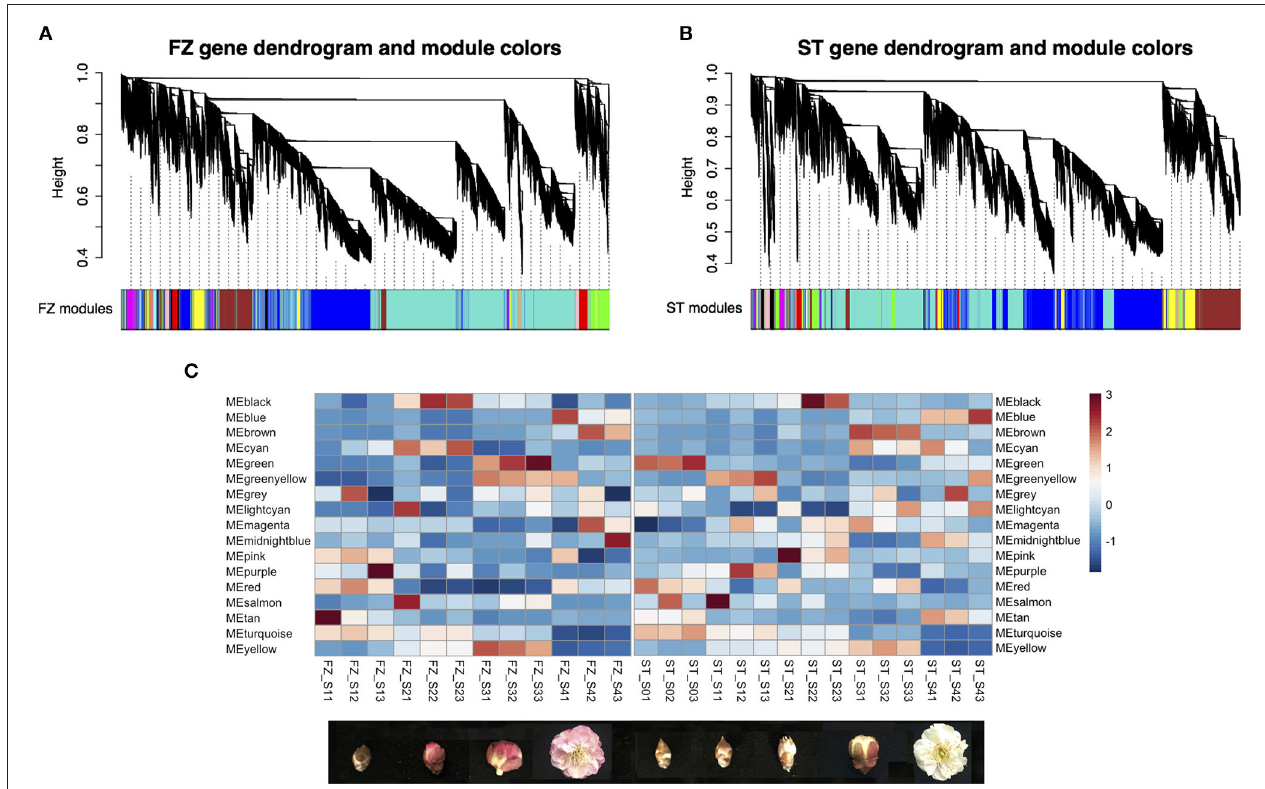
FIGURE 5 | Weighted co-expression network analysis for P. mume cultivar “Fenhongzhusha” (“FZ”) and “Subaitaige” (“ST”) (A) Gene modules identified for cultivar “FZ,” (B) Gene modules identified for cultivar “ST,” (C) Expression pattern of eigen-genes for 16 modules during flowering progression in two cultivars.